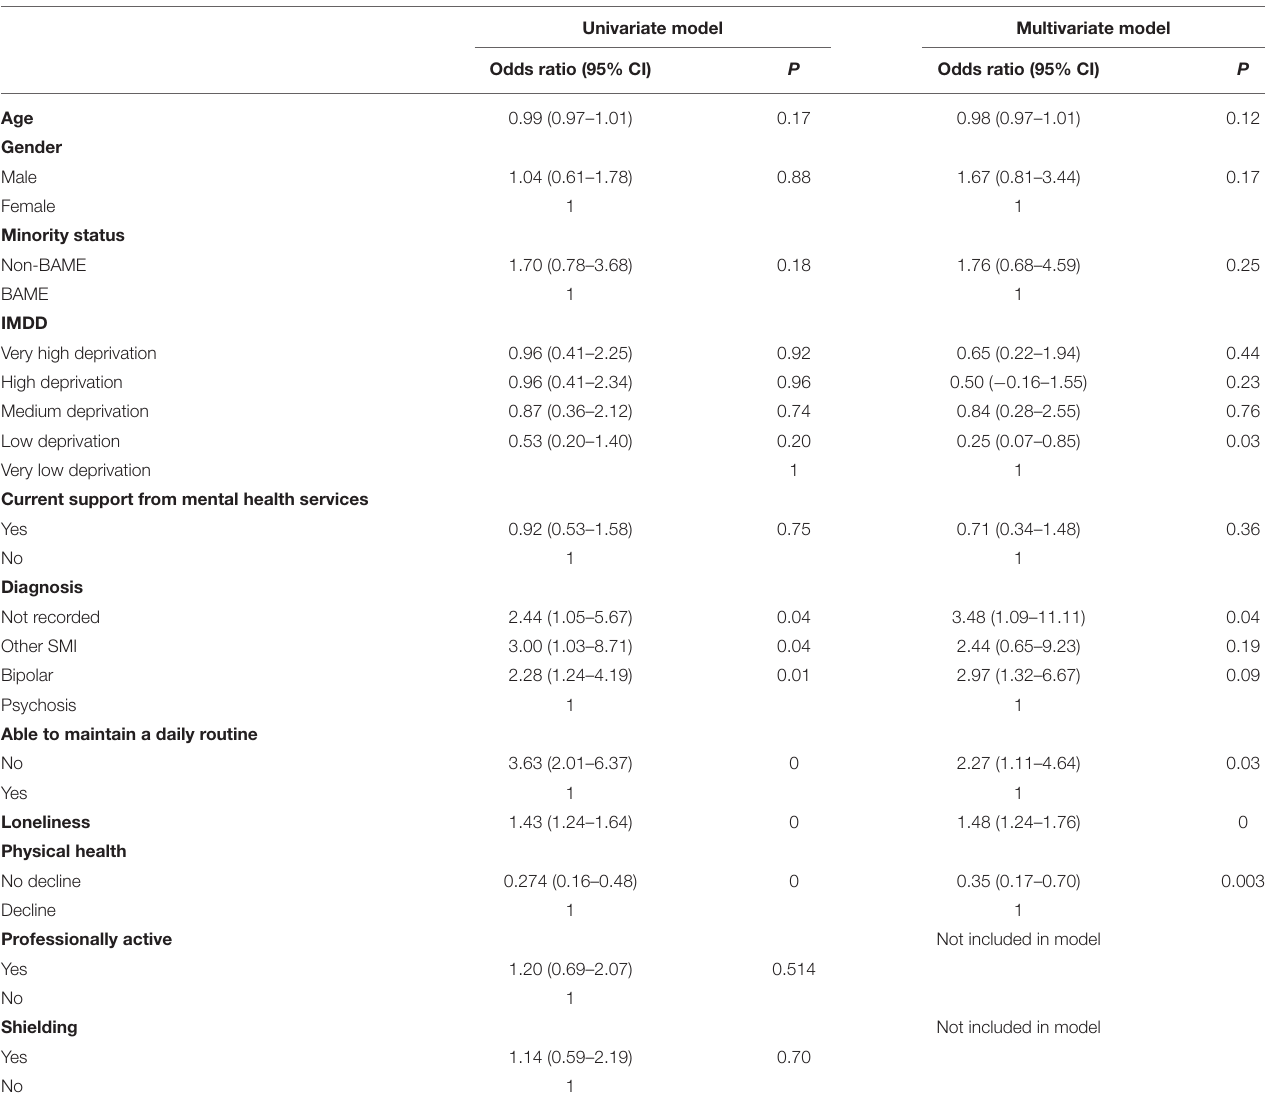
TABLE 4 | Factors associated with a deterioration in mental